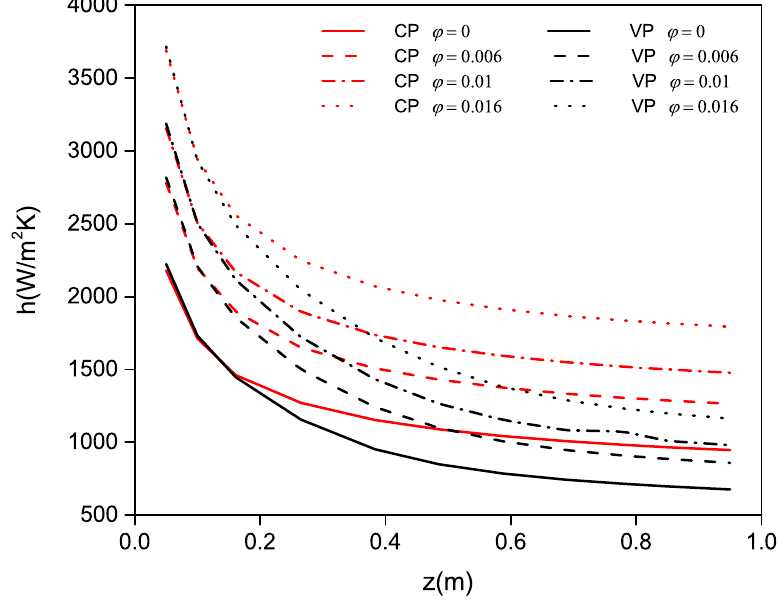
Figure 6. Local heat transfer coefficient obtained for Re = 1600, d np = 42 nm and Al 2 O 3 -water based nanofluids: Influence of temperature-dependent properties on the performances of the mixture